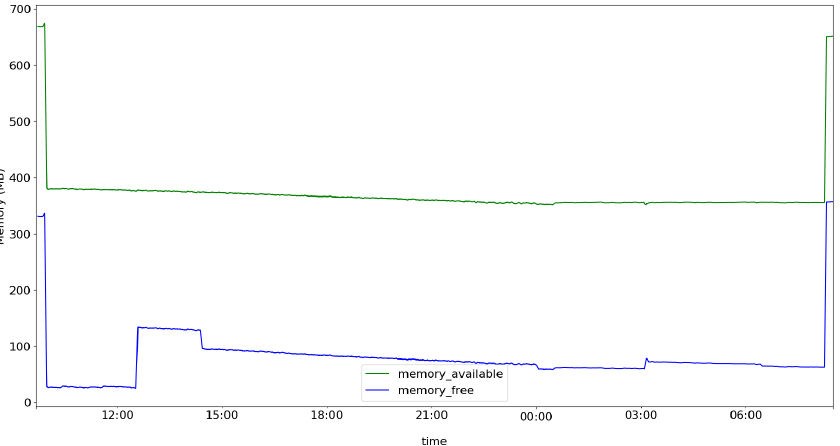
Figure 9. Memory and swap usage during analysis of network